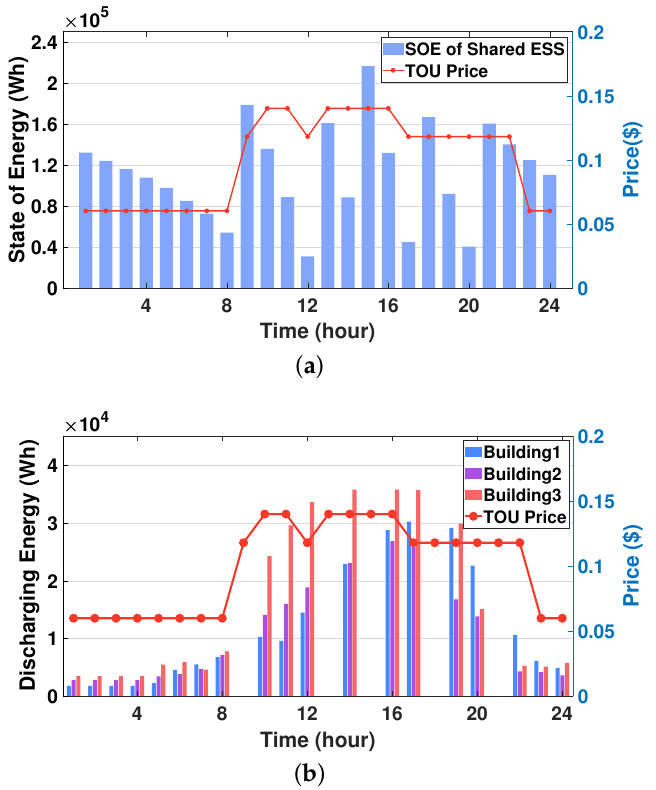
Figure 9. Simulation results for the SESS: ( a ) state of energy (SOE) (state SOE t ) of the SESS; ( b ) dis- charging energy schedules (action E SESS ) for the three t